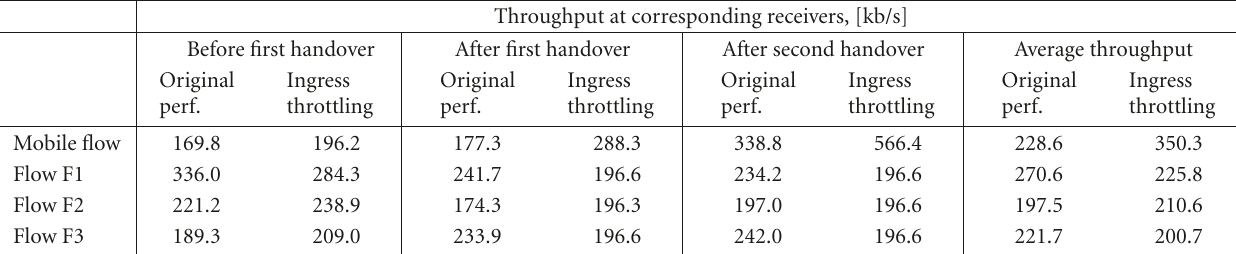
Table 1: The e ff ect of rate throttling in the case of node mobility. Throughput at corresponding receivers,